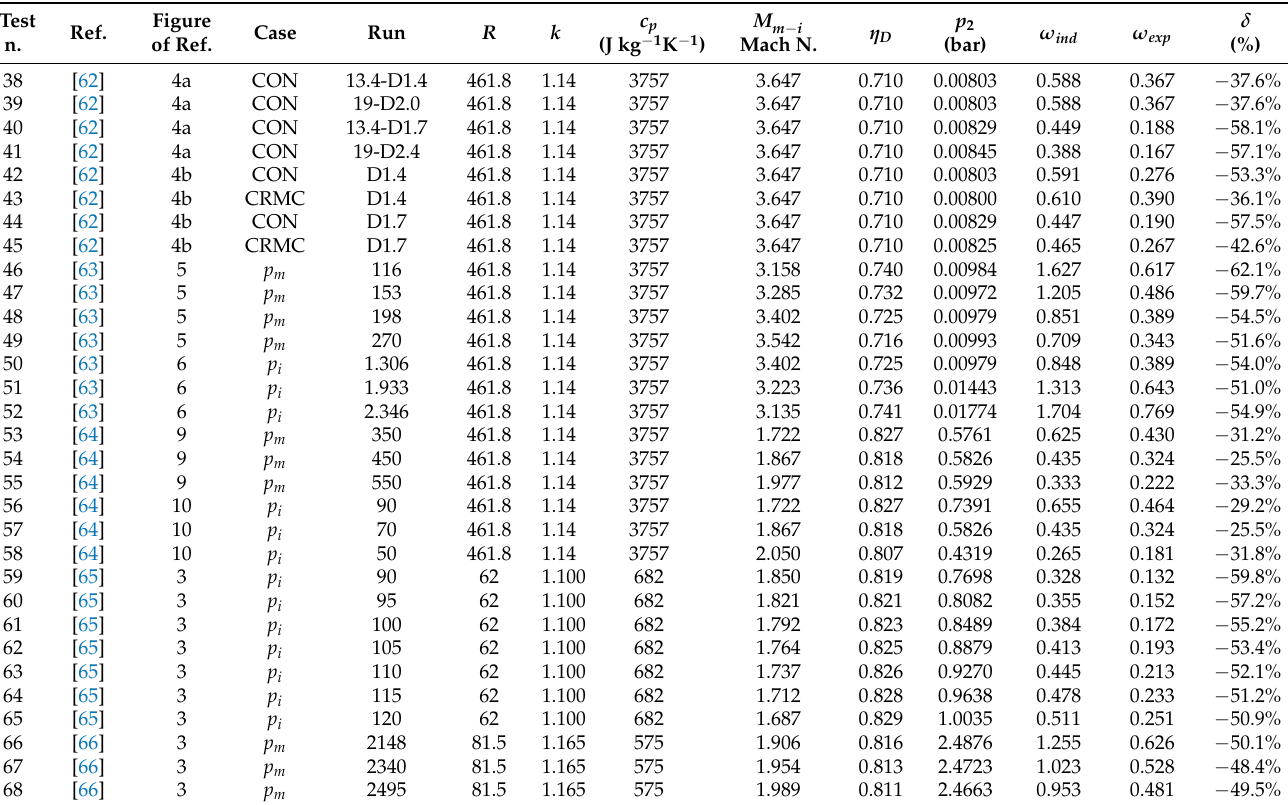
Table 6. Results of mathematical modelling applied to the second series of benchmark ejectors (Table 3), in order to determine the industrial entrainment ratio ω ind vs. the experimental one ω exp . Test